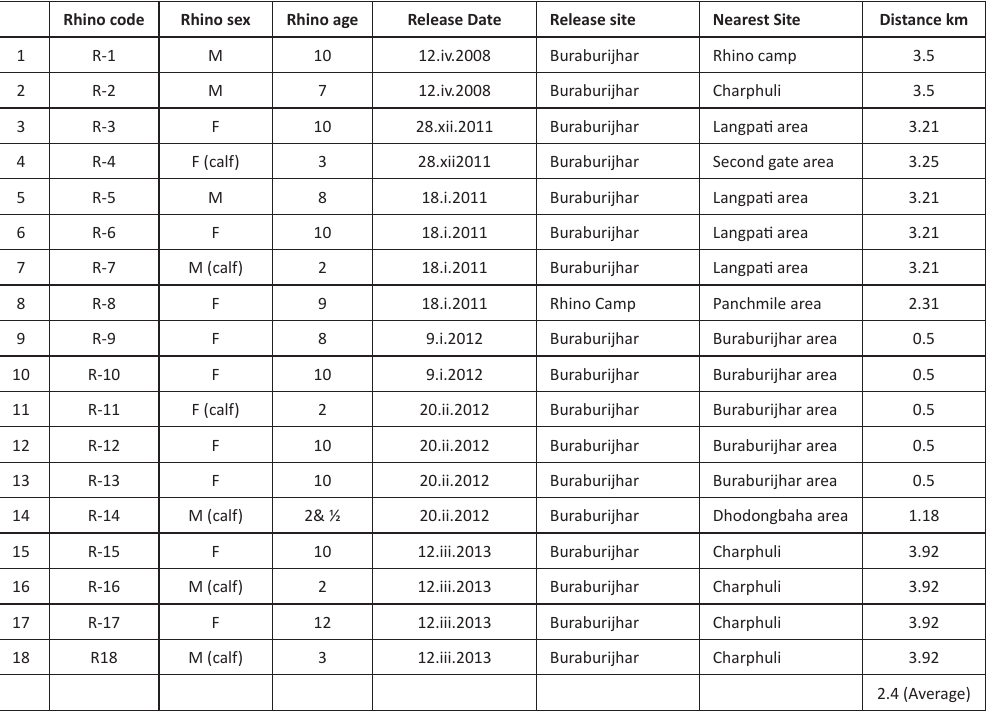
Table 4. Distance covered by rhinos between release sites just after the first day of release